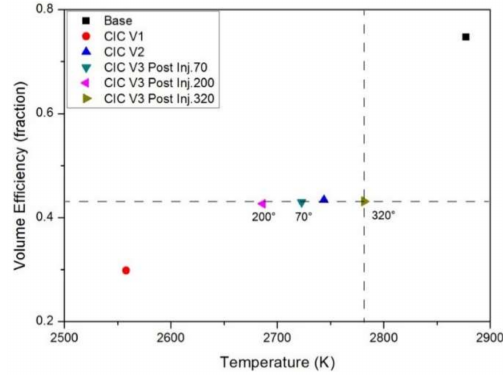
Figure 15. Comparison on volume efficiency for different variable valve control